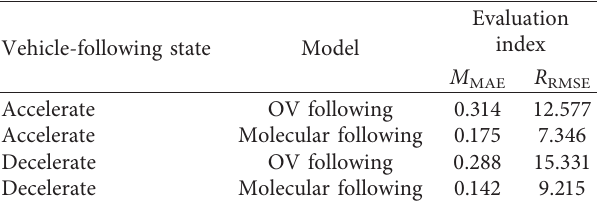
Table 2: Different model evaluation